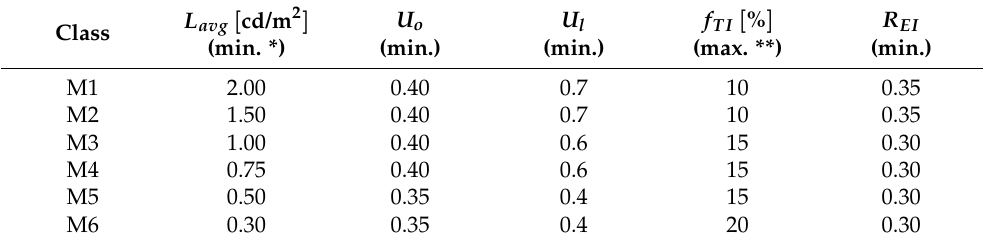
Table 1. M-lighting classes (for traffic routes, dry surface condition) according to the CEN 13201-2